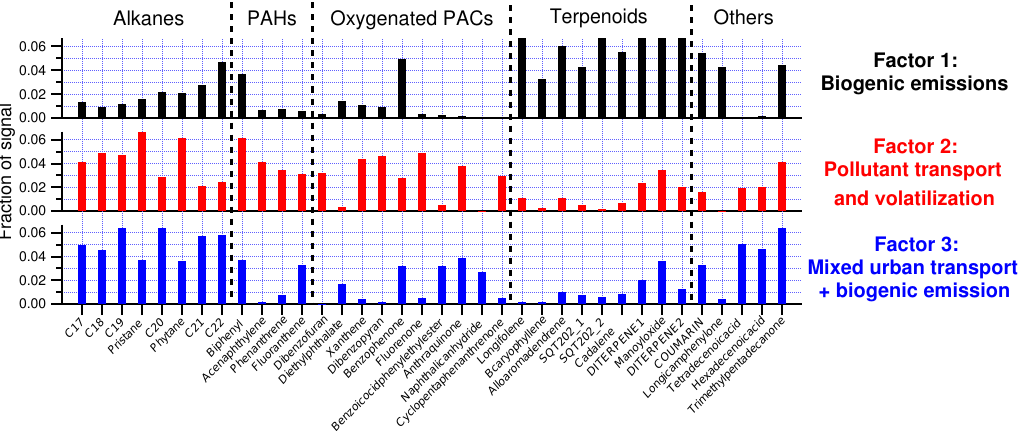
Figure 6. Factor profile of the three-factor solution using PMF. Factor 1 contains many biogenic terpenoids, while factor 2 is mainly com- prised of anthropogenic pollutants such as PAHs and PACs. Factor 3 may represent a mixed source of anthropogenic and biogenic